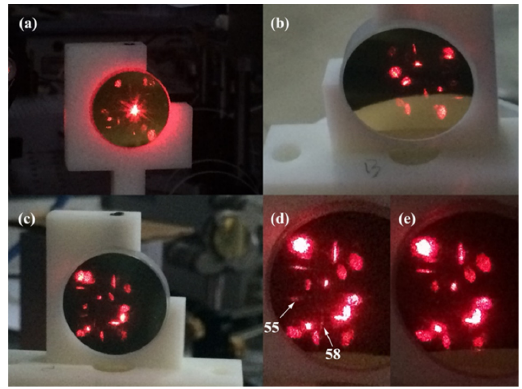
Figure 7. The measured spot shape and distribution on ( a ) mirror A, ( b ) mirror B, and ( c ) mirror C for the optimized three mirror-based gas cell. ( d ) The 55th and 58th spots on mirror C. ( e ) Spot distribution on mirror C after blocking the 54th spot.